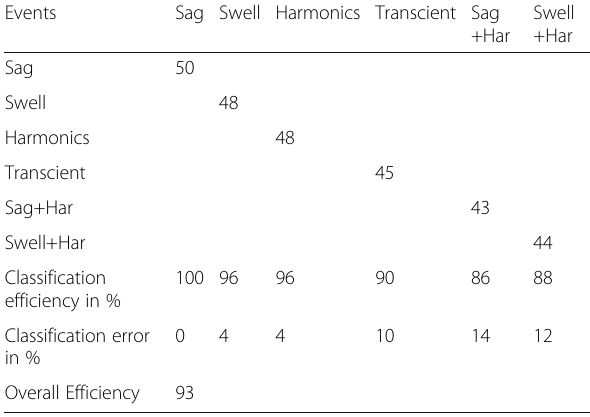
Table 3 Classification results under SNR 30 db